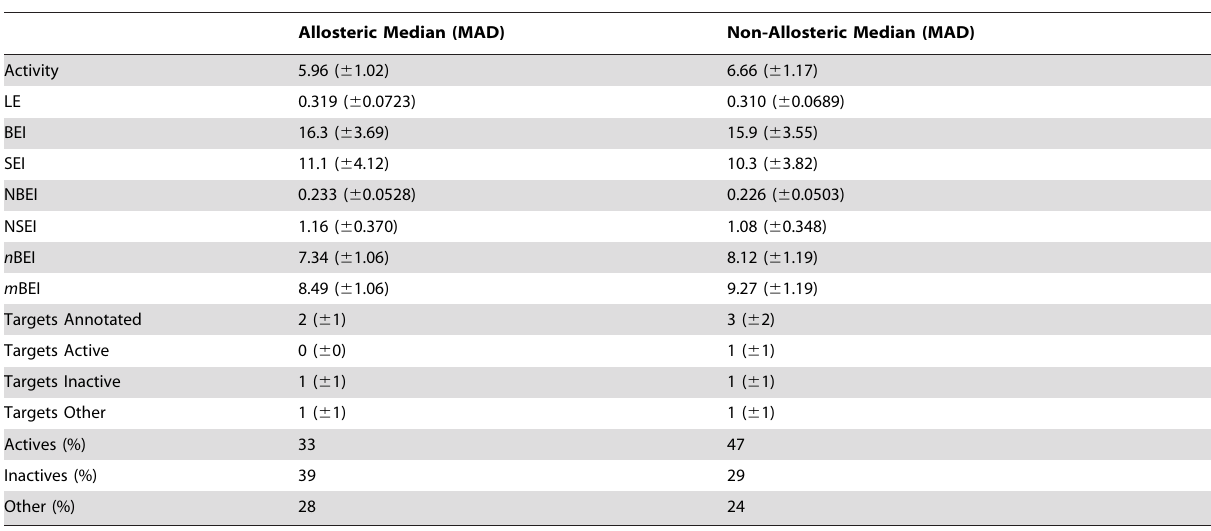
Table 2. Bioactivity measurements for allosteric and non-allosteric